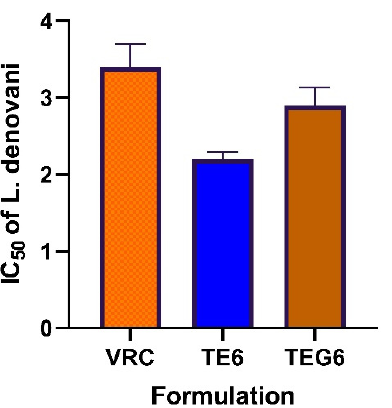
Figure 6. IC 50 of pure VRC, TEL, and TEG6 against L. donovani (Mean ± SD, n = 5).